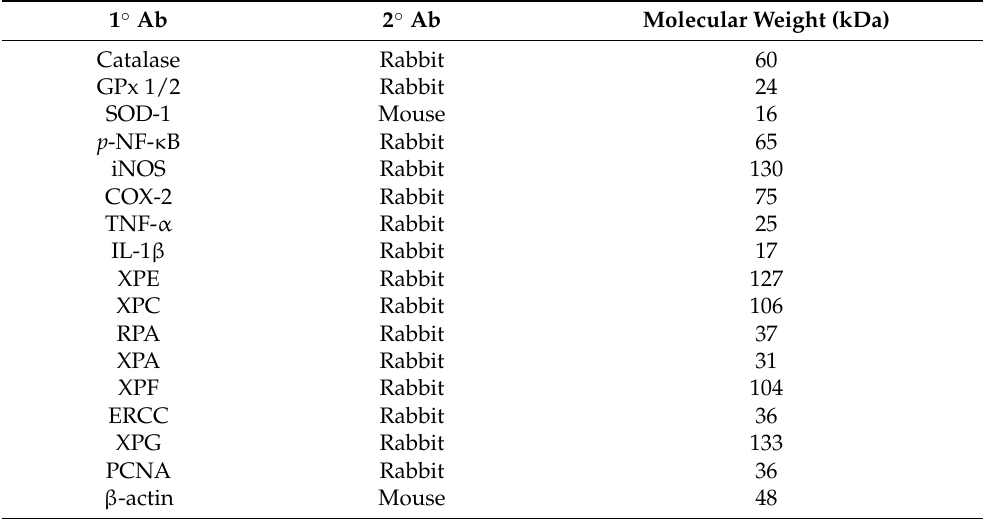
Table 1. The sources of the antibodies used in this